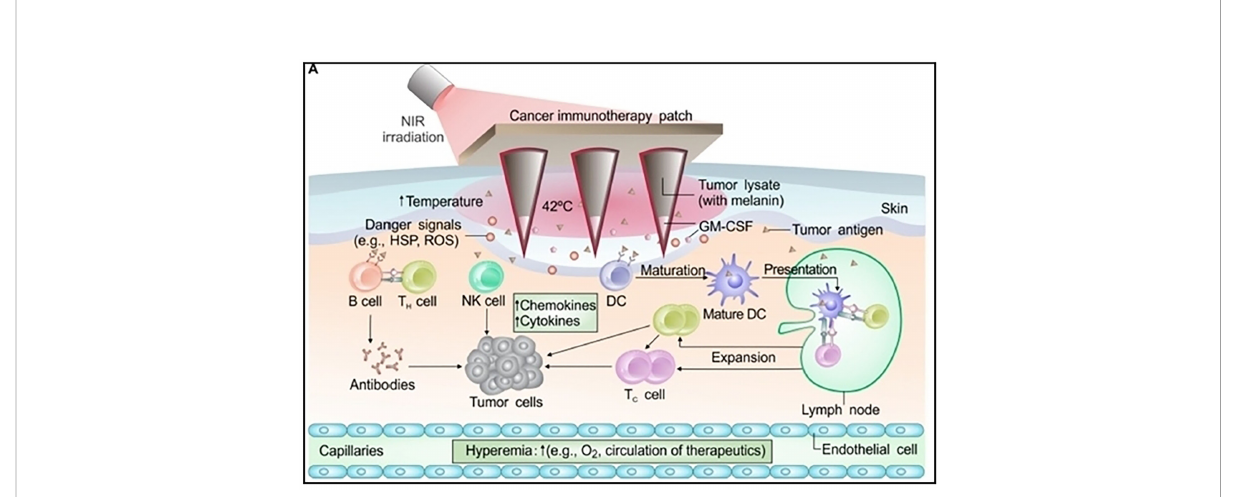
FIGURE 7 Schematic illustration of MN-based transdermal vaccination patch used for immunotherapy treatment of melanoma. Reproduced with permission from Ref (109). Copyright 2017,